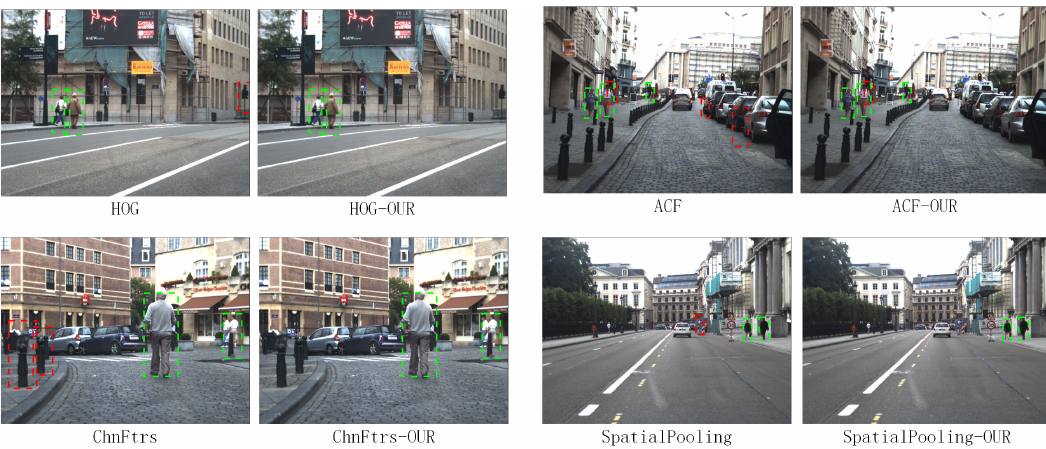
Figure 13. Results on the TUD-Brussels Pedestrian